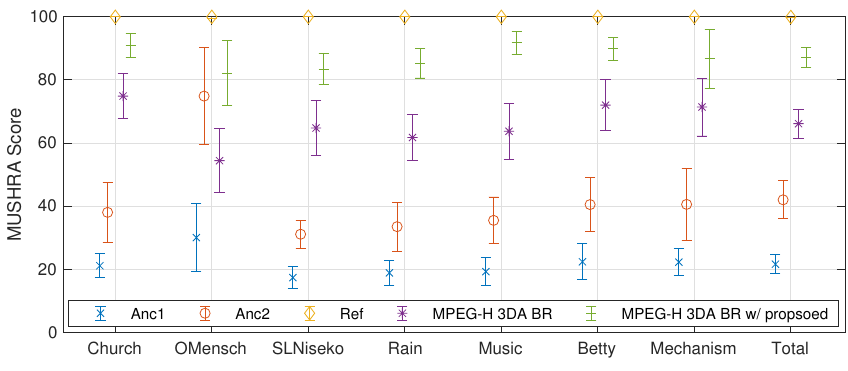
Figure 7. The MUSHRA test